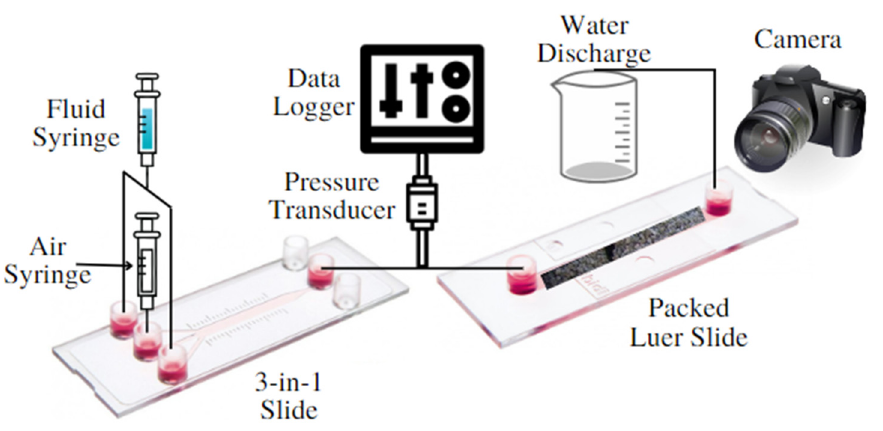
Figure 1. The bubble generation system and the experimental set-up for visualizing bubble flow in a packed microchannel. Microslide images are µ -Slide III 3in1 (left) and µ -Slide I Luer (right) from ibidi (ibidi, Martinsried, Germany).